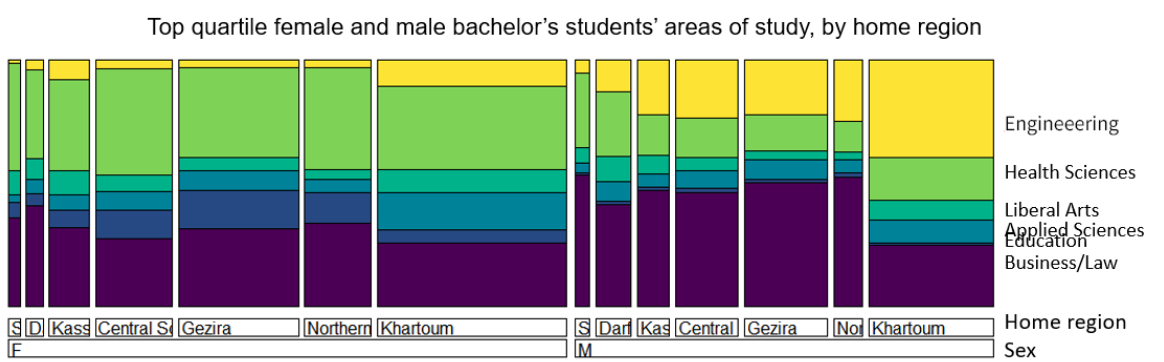
Figure 22. Double-decker plot of department category distributions by home region, for entering female and male bachelor’s students in the bottom three quartiles of academic ranking.